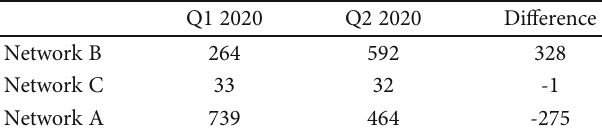
Table 11: Referral rates (cases per quarter) in the three networks during the fi rst half of